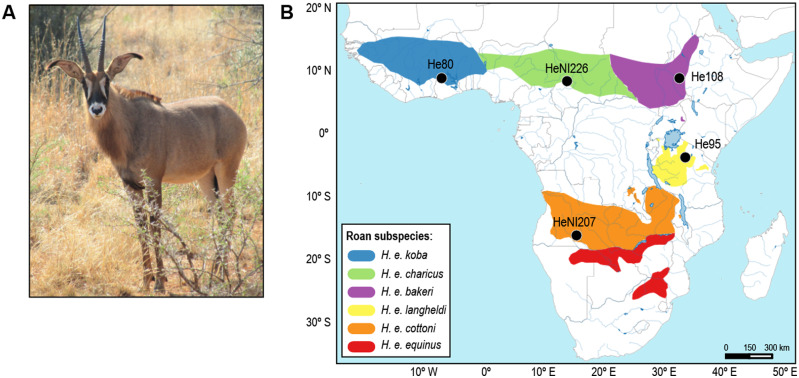
Roan antelope distribution and sampling. (A) Roan antelope (Hippotragus equinus). Photo by Raquel Godinho; (B) Geographic distribution of roan antelope subspecies according to Ansell (1972) and current species distribution, following IUCN SSC Antelope Specialist Group (2017). The geographic location of the five samples used in this study for whole-genome re-sequencing is represented by dark dots labelled with sample identifications (as in Table 1).